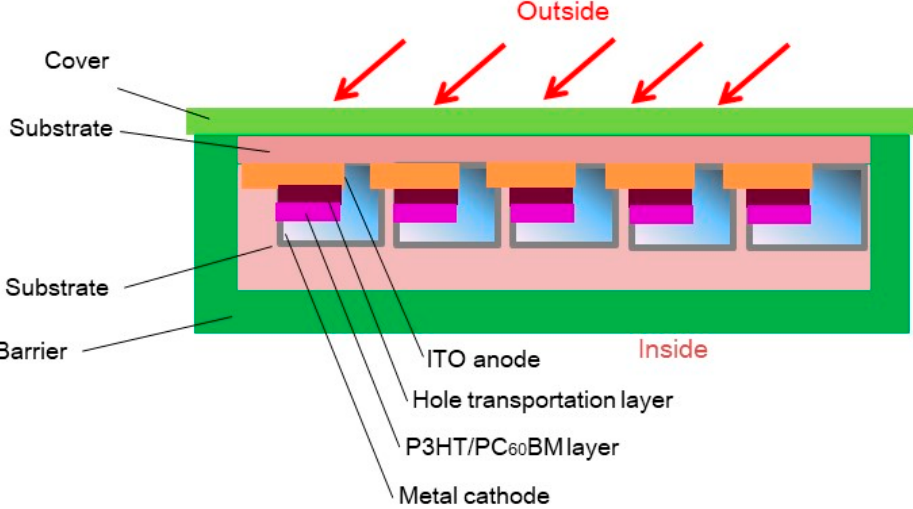
Figure 3. Drawing of transverse section of OPV device showing stacking structure.